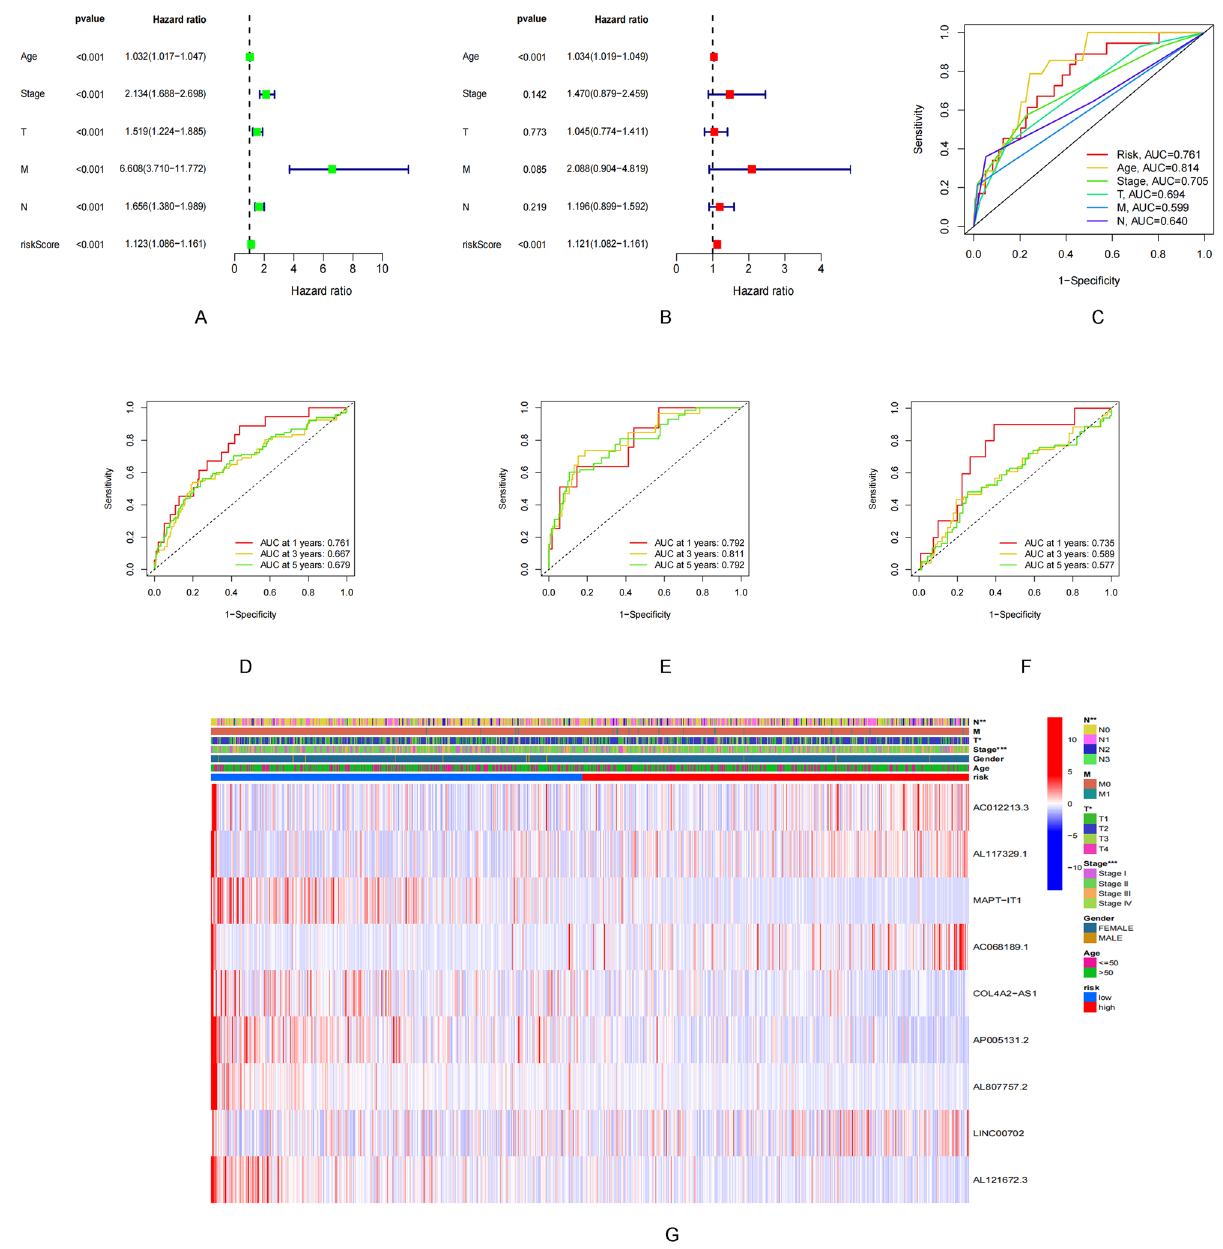
Figure 4. Evaluation and validation of the risk model. ( A , B ) Univariate and multifactor Cox analysis of risk score and clinical characteristics. ( C ) 1-year ROC curves for risk score and clinical characteristics. ( D – F ) 1-year, 3-year and 5-year ROC curves for the total dateset, training dateset, and validation dateset. ( G ) Differential expression of 9 ARSP-lncRNAs in different risk score and clinical